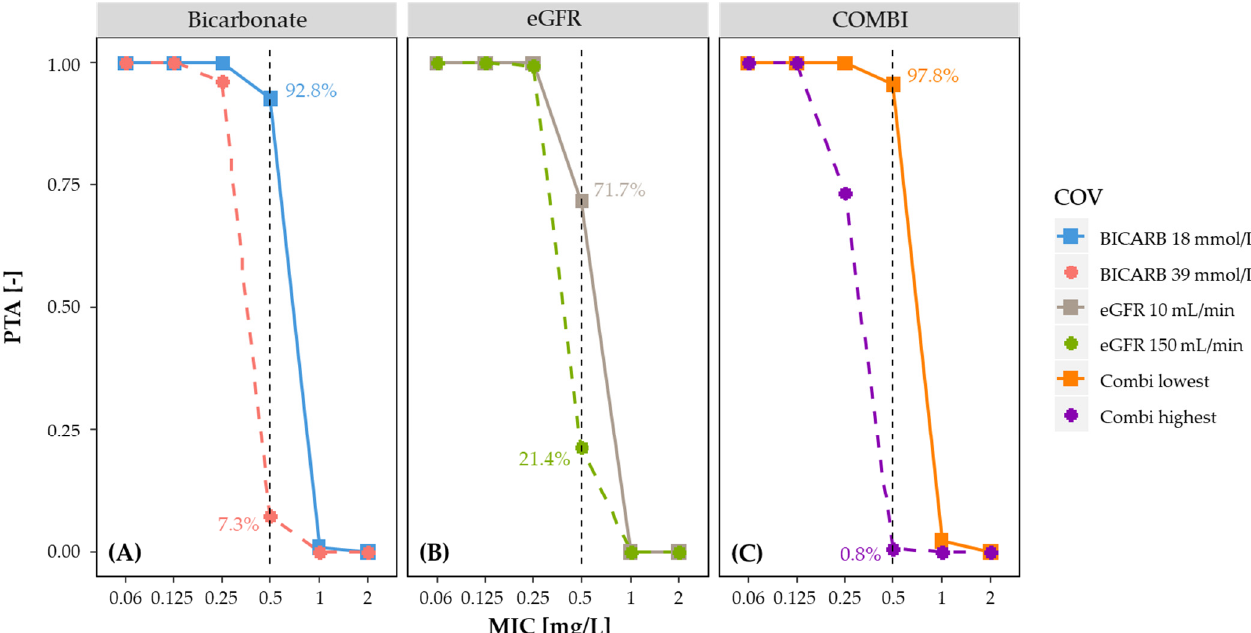
Figure 3. The impact of ( A ) the bicarbonate value, ( B ) the eGFR, and ( C ) the combination of the highest and lowest value of these two covariates (in the study population) on the PTA. The percentages represent the respective PTA at a breakpoint of 0.5 mg/L (dotted vertical line). A PTA ≥ 90% was considered satisfactory.